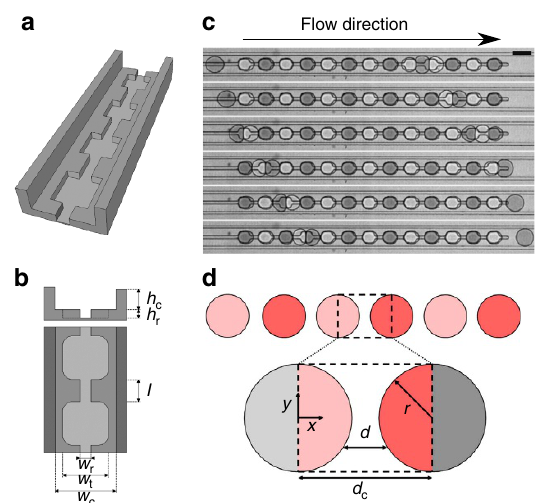
Figure 1 | Microfluidics for the control of minimal emulsions. ( a ) Sketch of the trapping channel based on rails and anchors 34,42,43 . ( b ) The geometry of the channels determines the spacing distance between droplets ( h c ¼ 20 m m, h r ¼ 15 m m, w r ¼ 20 m m, w t ¼ 80 m m, w c ¼ 100 m m, l varies between 36 and 6 m m). ( c ) Time sequence (100ms interval) of droplets buffering each other from one local minimum in surface energy to the next (scale bar, 100 m m). ( d ) Sketch of the membrane model used to describe the transport process in the array based on the transport through a single membrane (see Supplementary Fig. 2 and Supplementary Note 2).